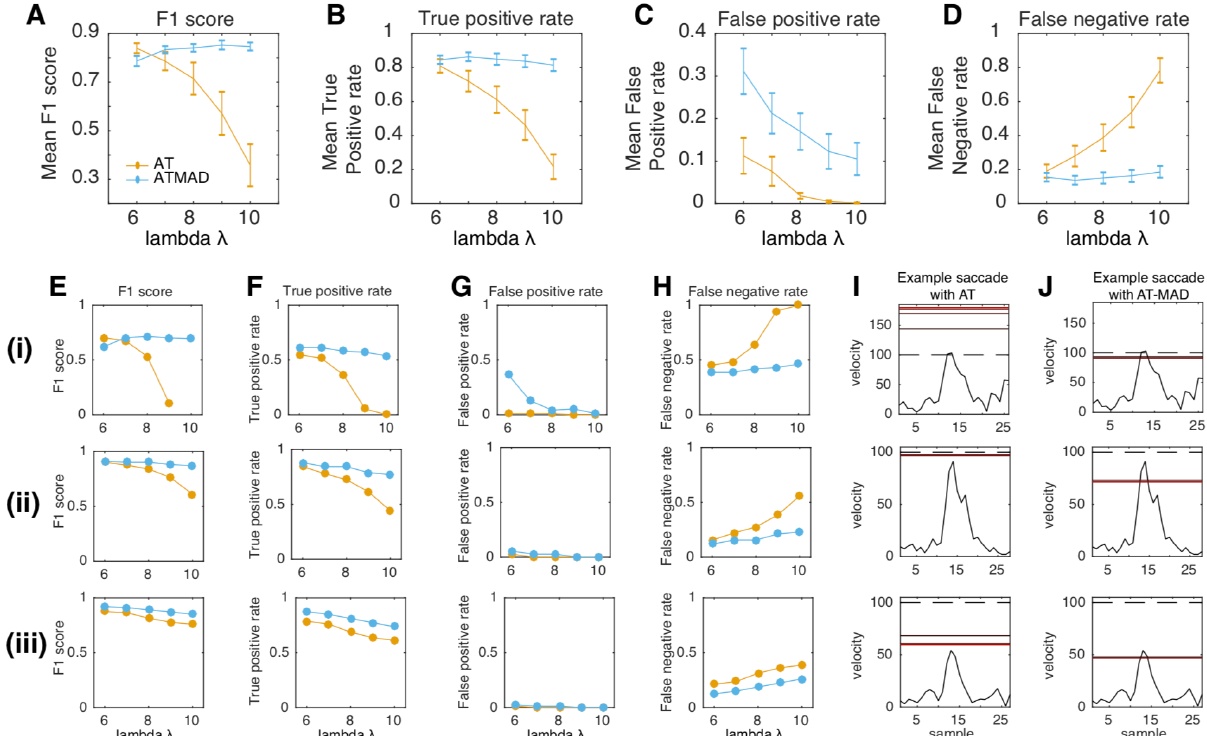
Figure 5. AT-MAD outperforms AT on real world data (A-D) Performance of the AT (orange) and AT-MAD (blue) algorithms on two minutes of human gaze data (n=12), depicted as the (A) F1 score, (B) True positive rate, (C) False positive rate, and (D) False negative rate. AT-MAD outperforms AT for all levels of lambda greater than 6. (E-H) Same as (A-D) but for three individual subjects (i-iii). In all three subjects, AT-MAD outperforms AT for lambda >6. In one subject (Ei), the F1 score is undefined because precision and recall are zero (I,J) Example saccades in these subjects that AT could not detect (I) but AT-MAD could (J). Dashed line represents the initial threshold, and solid red lines are threshold on subsequent iteration, with darker (lighter) representing earlier (later)